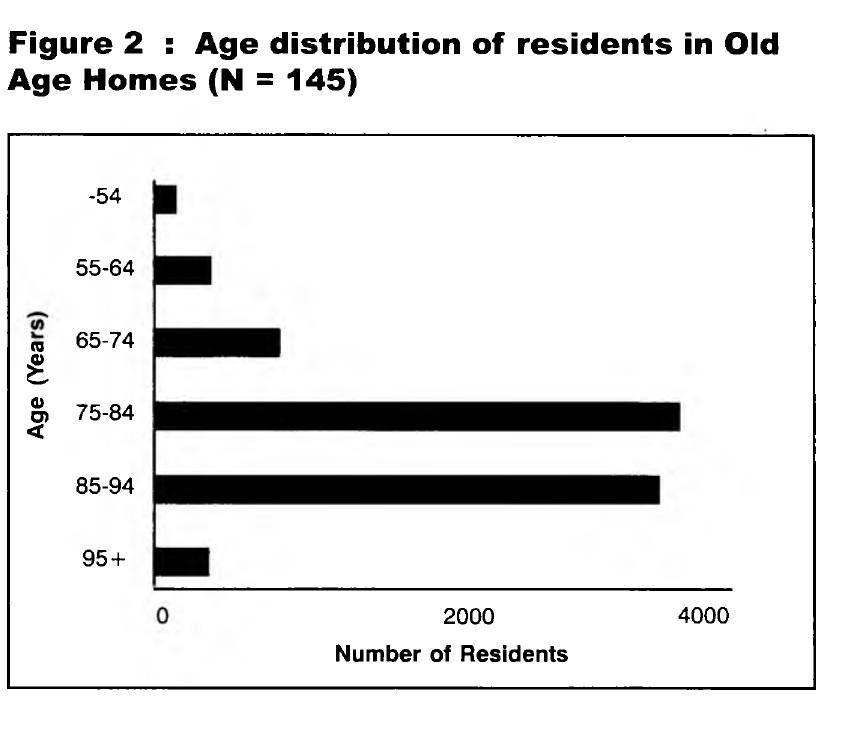
Figure 2 : Age distribution of residents in Old Age Homes (N = 145)